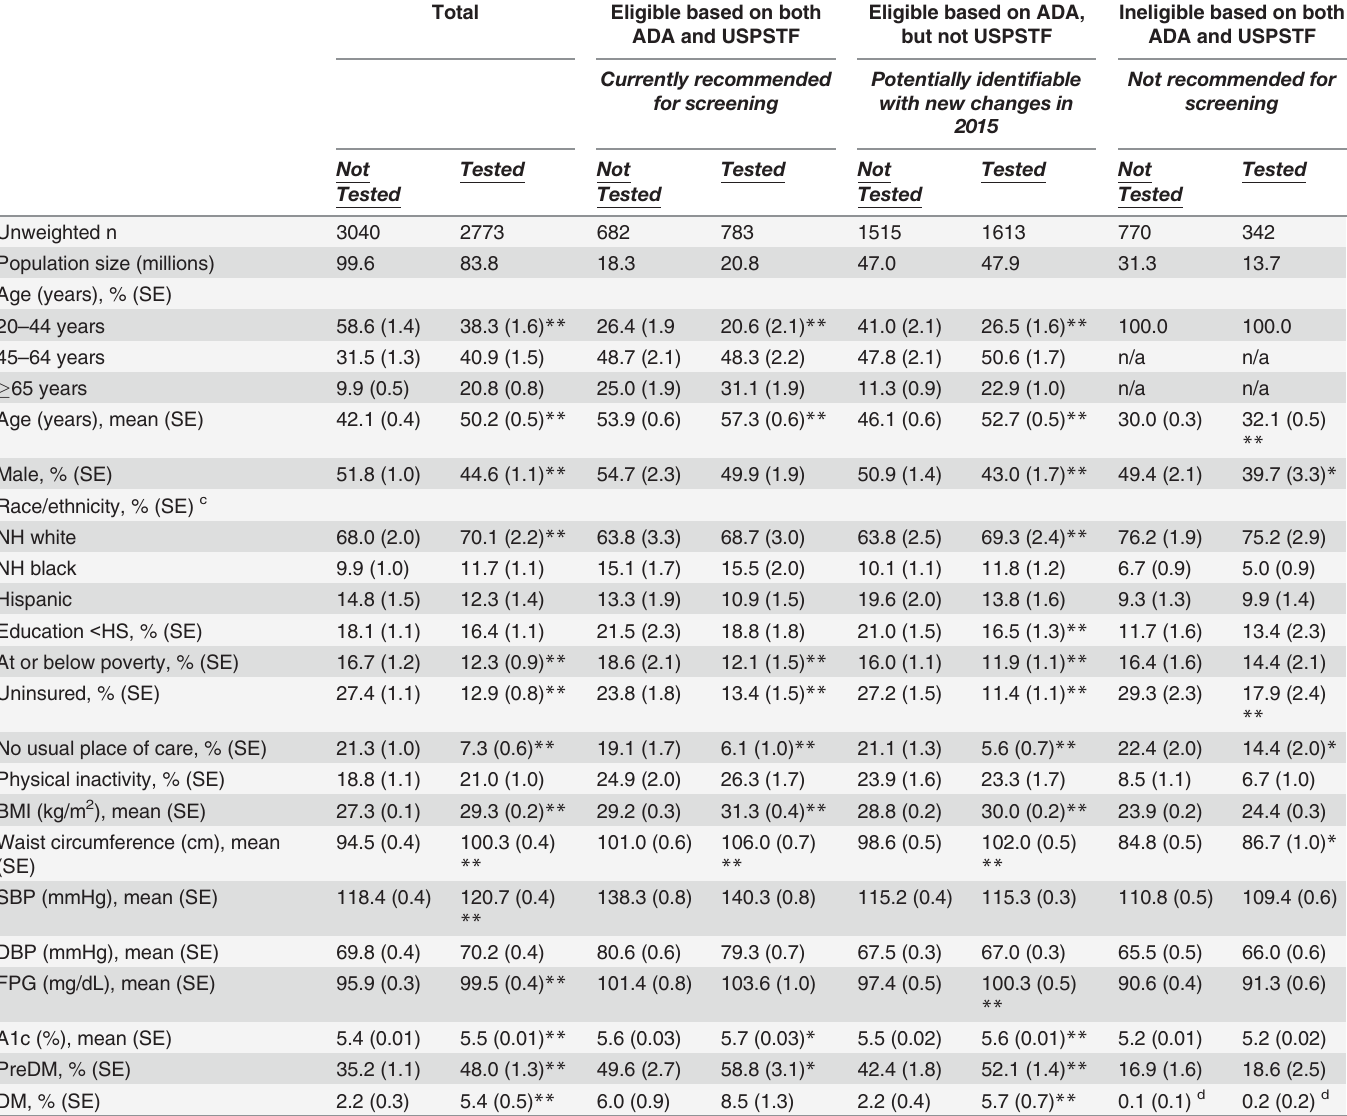
Table 2. Characteristics of adults without diagnosed diabetes according to US guideline eligibility groups a who did and did not report receipt of glucose testing b in past 3 years.